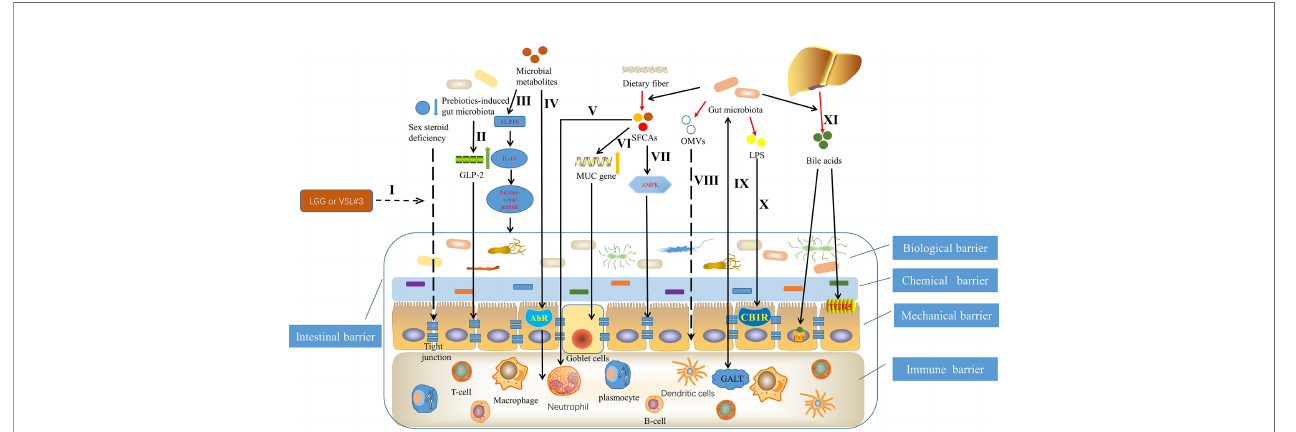
FIGURE 1 | Mechanisms underlying that gut microbiota can affect the structure and function of intestinal barrier. I Probiotics Lactobacillus rhamnosus GG (LGG) or commercially available probiotic supplement VSL#3 enhanced the integrity of intestinal barrier through inhibiting the decreased expression of tight junction protein in intestinal epithelium, caused by sex steroid de fi ciency (Li et al., 2016a). II Prebiotics-induced gut microbiota improved intestinal barrier function, depending on glucagon-like peptide-2 (GLP-2) (Cani et al., 2009). III Microbial metabolites such as taurine, histamine and spermine, protected the intestinal barrier by shaping the host-microbiome interface through co-regulating NLRP6 in fl ammasome signaling, epithelial interleukin-18 (IL-18) secretion, and downstream antimicrobial peptide pro fi les (Levy et al., 2015). IVCommensal lactobacilli ’ s metabolites of tryptophan contributed to immune barrier by binding to aryl hydrocarbon receptor (AhR) (Zelante et al., 2013). V Short chain fatty acids (SCFAs), originating from fermentation of dietary fi ber by gut microbiota (Ulici et al., 2018), promoted intestinal homeostasis through several hematopoietic cell types (Levy et al., 2017), such as neutrophil (Vinolo et al., 2011). VI SCFAs contributed to maintaining mucosal immunity by up regulating mucin (MUC) gene expression in intestinal epithelial goblet cells (Gaudier et al., 2004). VII SCFAs promoted tight junction assembly by activating adenosine monophosphate-activated protein kinase (AMPK) (Peng et al., 2009). VIII Outer membrane vesicles (OMVs), produced by pathogenic and commensal Gram-negative bacteria, disrupted the integrity of the mucosal epithelium (Kaparakis-Liaskos and Ferrero, 2015). IX The regulated cross talk between gut microbiota and gut-associated lymphoid tissue (GALT) contributed to the intestinal barrier (Kalinkovich and Livshits, 2019). X Lipopolysaccharide (LPS) regulated the intestinal barrier by activating intestinal cannabinoid type 1 receptor (CB1R) (Zoppi et al., 2012). XI Bile acids, an intestinal metabolite, protected the intestinal barrier, controlled by the gut microbiota through the farnesoid X receptor (FXR) and the G protein-coupled bile acid receptor 1 (GPBAR1) or (TGR5) (Levy et al.,